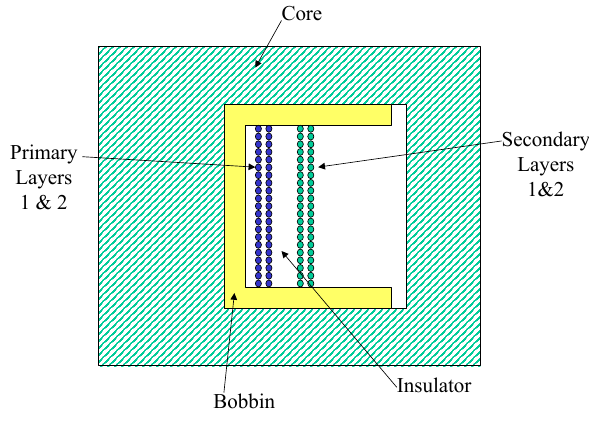
Figure 5: 2D model using individual Layers